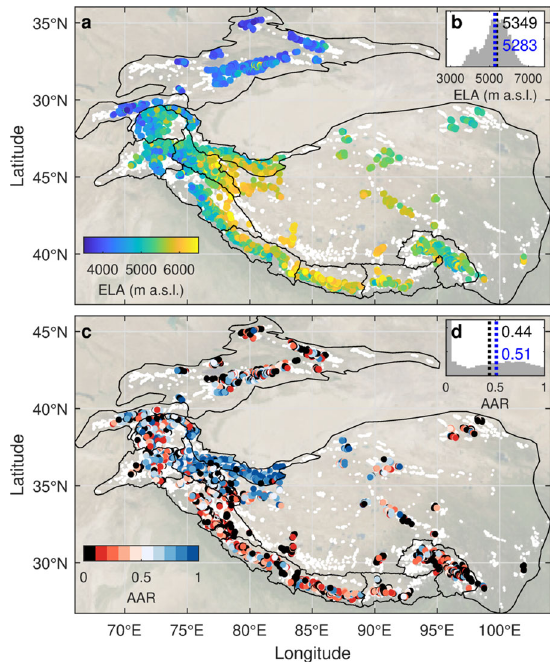
Fig. 2 The state of studied glaciers in High Mountain Asia in 2000 – 2016. a The spatial pattern of equilibrium line altitudes (ELAs) determined in this study. White dots depict the full distribution of glaciers in the region. Black lines depict the outlines of subregions following 14 . b The region-wide histogram of ELA values, also indicating median (black) and area-weighted mean (blue) values. c The spatial pattern of accumulation area ratio (AAR) values determined in this study. d The region-wide histogram of AAR values, also indicating median (black) and area-weighted mean (blue) values. Background is the August 2004 NASA Blue Marble 75